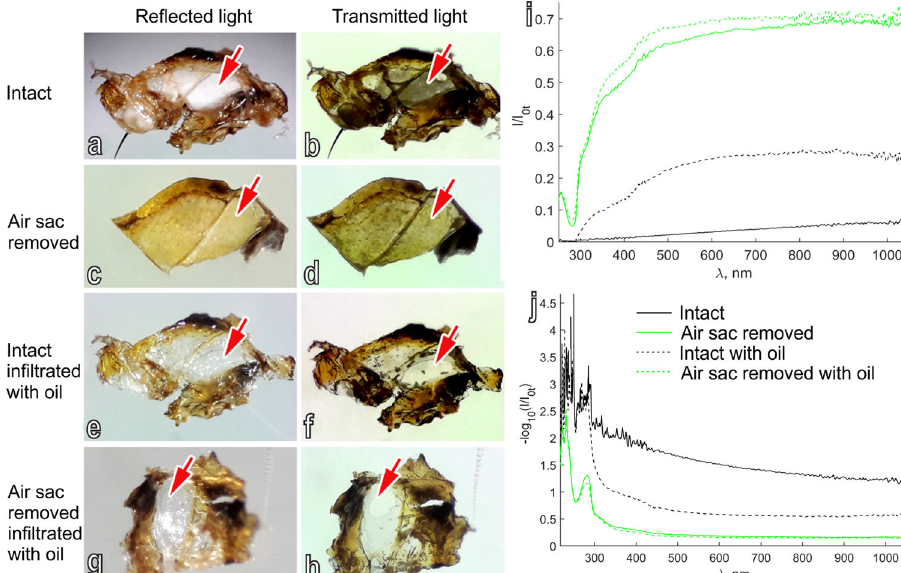
Fig. 8 Thoracic white patches of Bactrocera oleae photographed with re fl ected and transmitted light. Thoracic white patches photographed with epi- (re fl ected light) ( a , c , e , g ) and trans- (transmitted light) (b , d , f , h ) illumination, in different conditions: (1) intact ( a , b ); (2) with the underlining air sac removed ( c , d ); (3) intact, in fi ltrated with oil ( e , f ); and (4) with the underlining air sac removed, in fi ltrated with oil ( g , h ). Transmission ( i ) and absorption ( j ) spectra of the white patches in the different conditions, intact (black solid line); with the underlining air sac removed (green solid line); intact, in fi ltrated with oil (black dashed line); and (4) with the underlining air sac removed, in fi ltrated with oil (green dashed